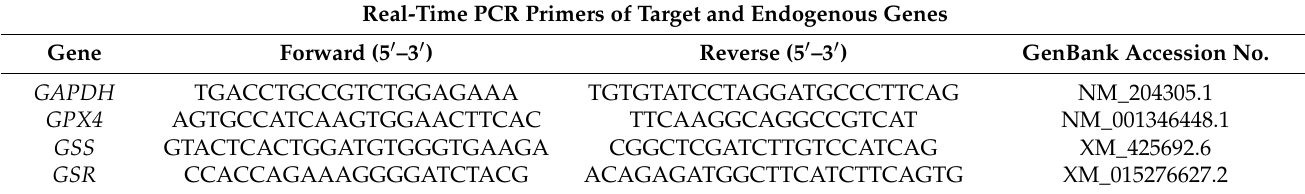
Table 3. Primers of target and endogenous genes.